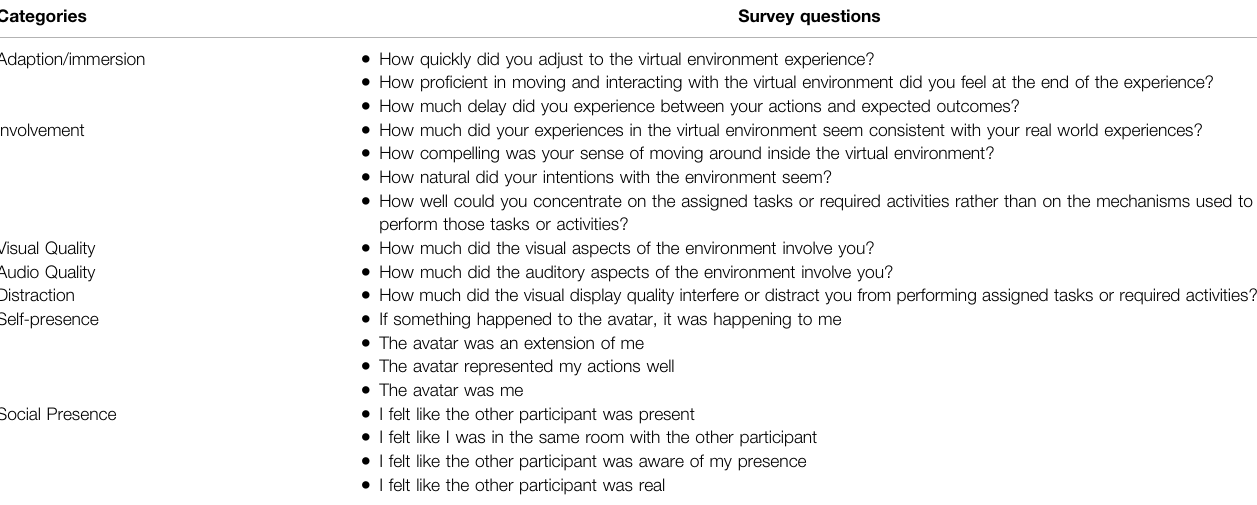
TABLE 1 | User experience and presence questionnaire. Categories Survey